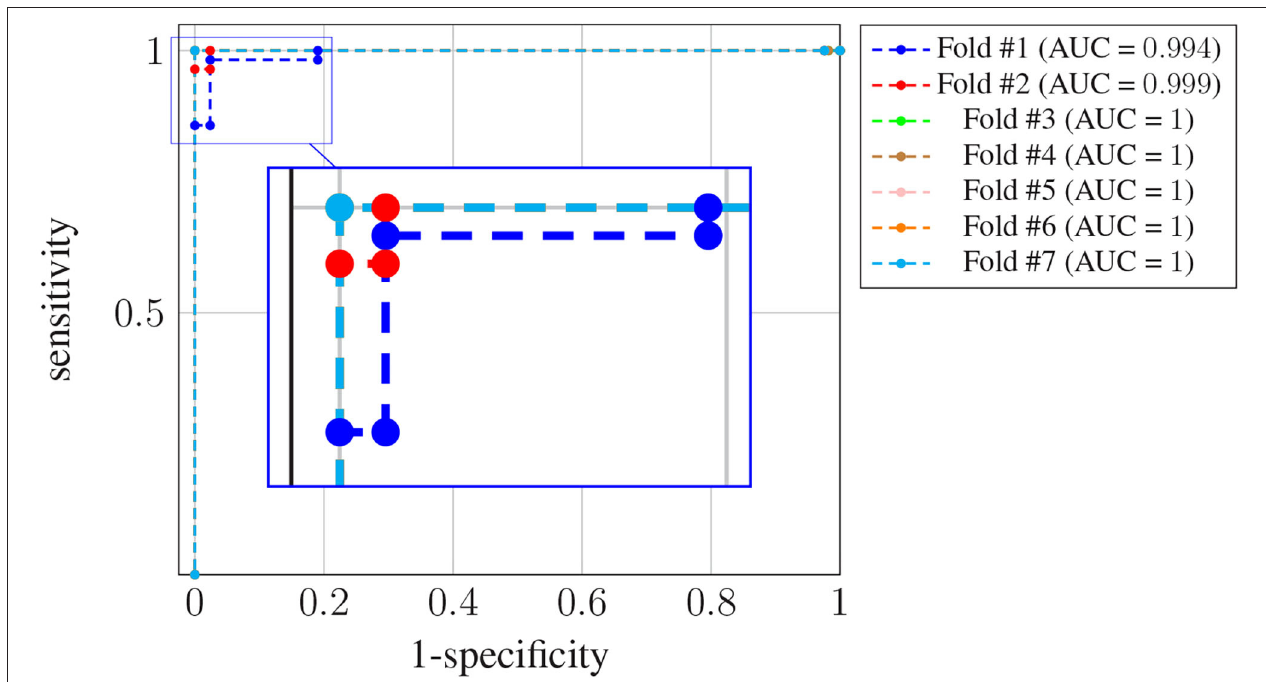
FIGURE 4 | ROC curves for subject-unaware data partitioning strategy. Each curve corresponds to a different fold, and the attained AUC is, in every case, shown in the